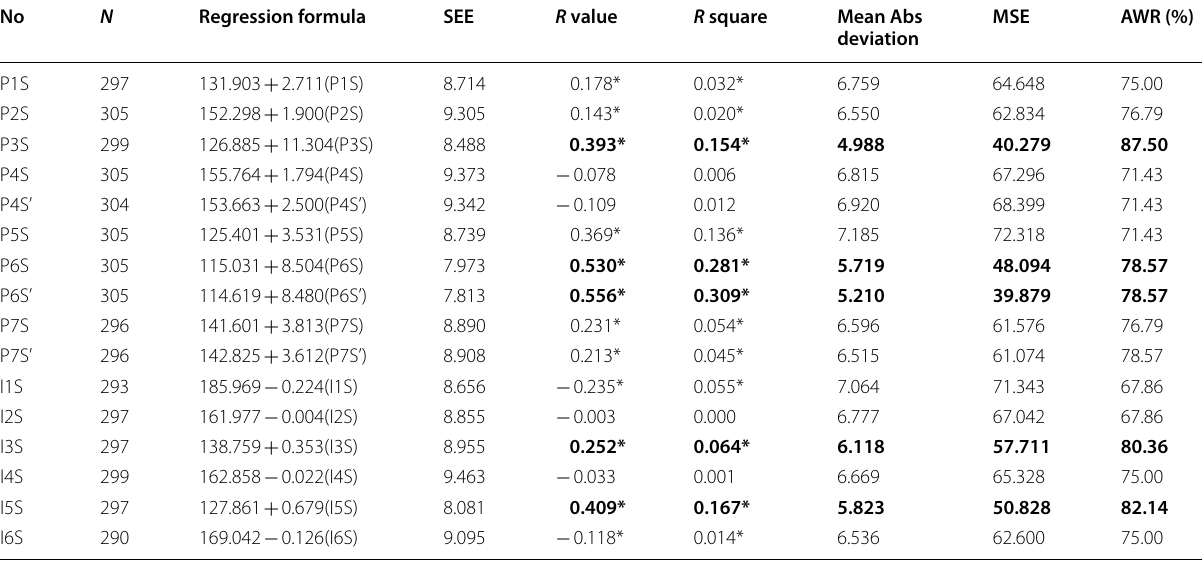
Table 8 Correlation and regression statistics for individual parameters and indexes of sacral morphometric against stature in validation analysis (Lai et al. 2020)